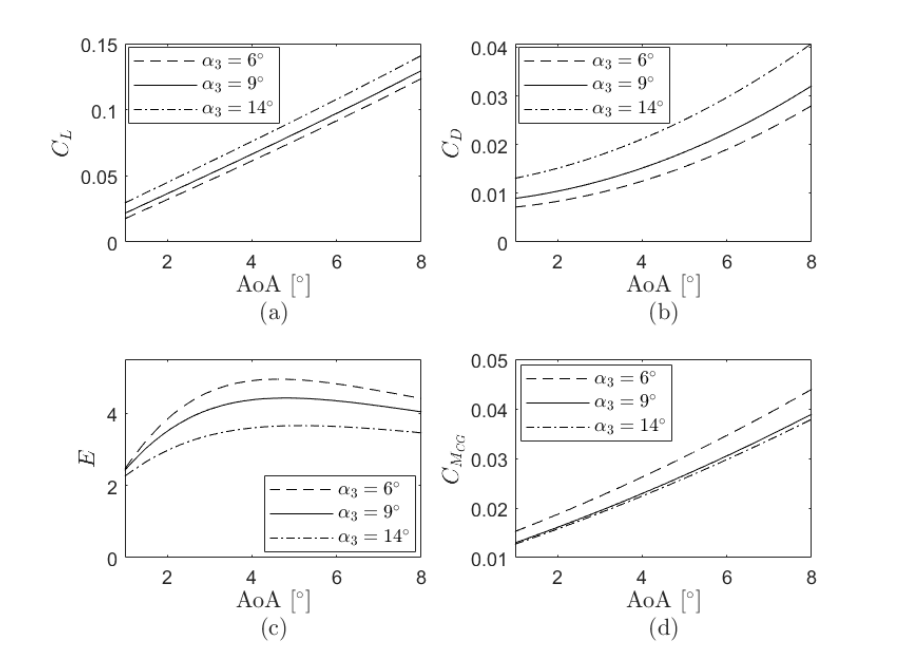
Figure 8. Variations of the aerodynamic parameters due to the modifications in α 3 , ( a ) C L vs. AoA ,